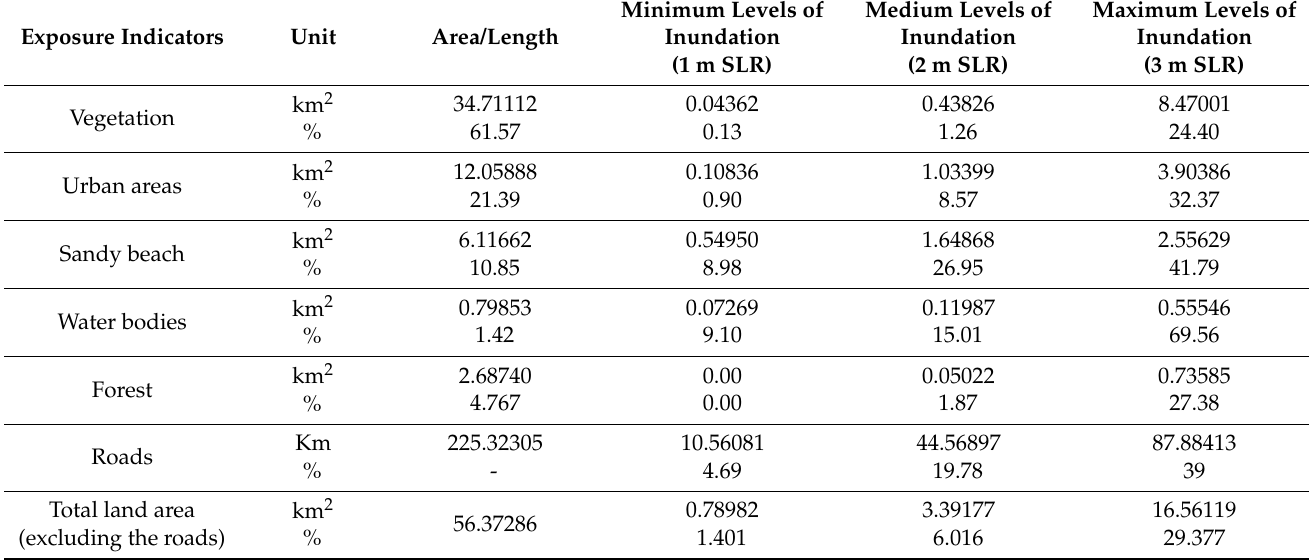
Table 2. SLR impacts across exposure indicators [37].